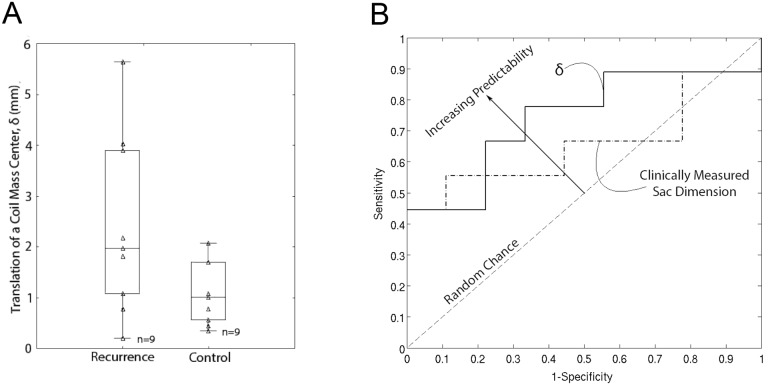

(A) Coil mass center translation, δ, in the recurrence (N = 9) and control cohorts (N = 9). The box and whisker plots show quartiles and the p-values are from one-tail Mann-Whitney U test for hypothesizing that δ will be higher in the recurrence cohort than in control (null hypothesis, H
0: δRECR ≤ δCTRL; alternative hypothesis, H
A: δRECR > δCTRL). The triangles indicate raw data values. (B) Receiver operator curve showing the predictability of δ in recurrence (N = 9) and control (N = 9) aneurysms. δ is a better predictor of recurrence than clinically measured sac size, as it has a larger area under the curve or AUC (AUC = 0.74). Optimal sensitivity and specificity in differentiating recurrence aneurysms from control was found at δ = 1.1 mm.